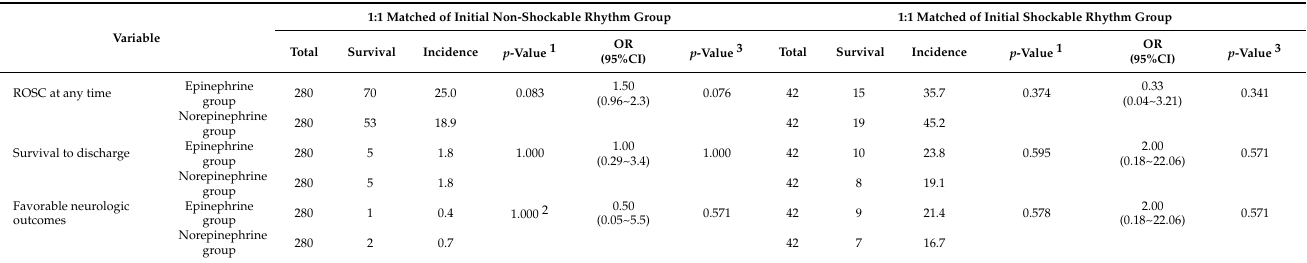
Table 3. The subgroup analysis according to the initial rhythm on the effect of prehospital epinephrine administration by EMS providers during OHCA on survival to discharge and favorable neurologi- cal outcomes.